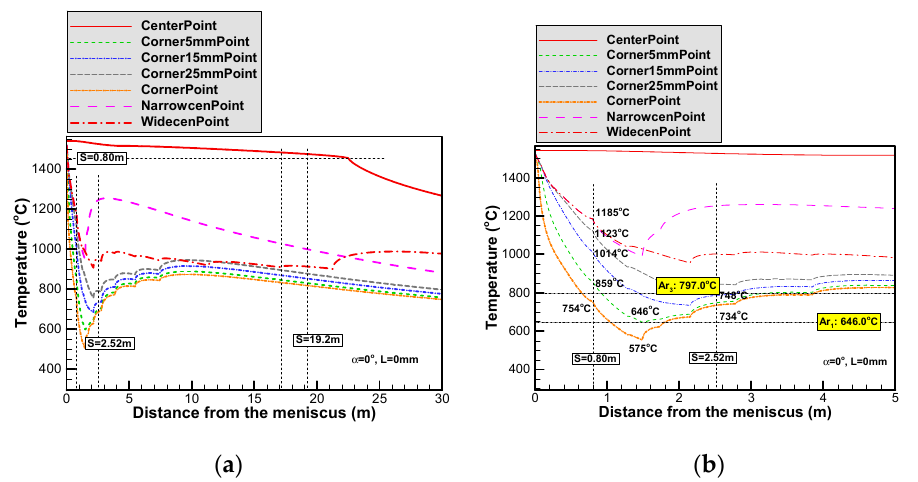
Figure 10. Temperature distribution under intensive cooling in foot roller zone of the right-angle slab. ( a ) The whole process of slab solidification, ( b ) enlarged view of mould and bending section. Table 4 lists the detailed temperature values at the distances of 0 mm, 5 mm, 15 mm, and 25 mm along the wide face of the right-angle slab of the S355 steel at the selected characteristic positions, including the mould exit, the end of the foot roller, the beginning of the bending, and the beginning and end of the straitening segment. If an intensive cooling process is adopted, the temperature at the position of 5 mm from the slab corner can be reduced to 646 ◦ C at the foot roller ending (S = 1.5 m), which is in the pure ferrite phase. Although the temperatures can rise up to 748 ◦ C, it is still below the measured temperature of the Ac 3 point (852.6 ◦ C) of S355 steel. Therefore, the slab cannot obtain a pure austenite phase; when the slab begins to bend (S = 2.52 m) at this situation, the cracks are prone to occur during the bending process. The temperature at the position of 15 mm from the slab